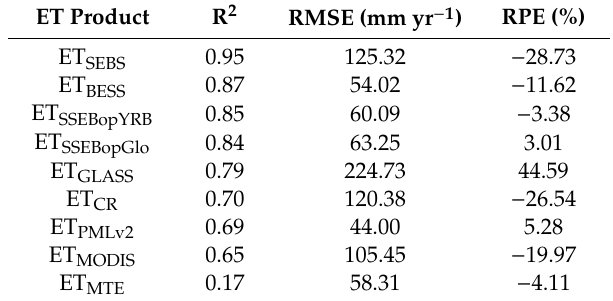
Table 3. Evaluation of average annual ET during the years 2003–2015.